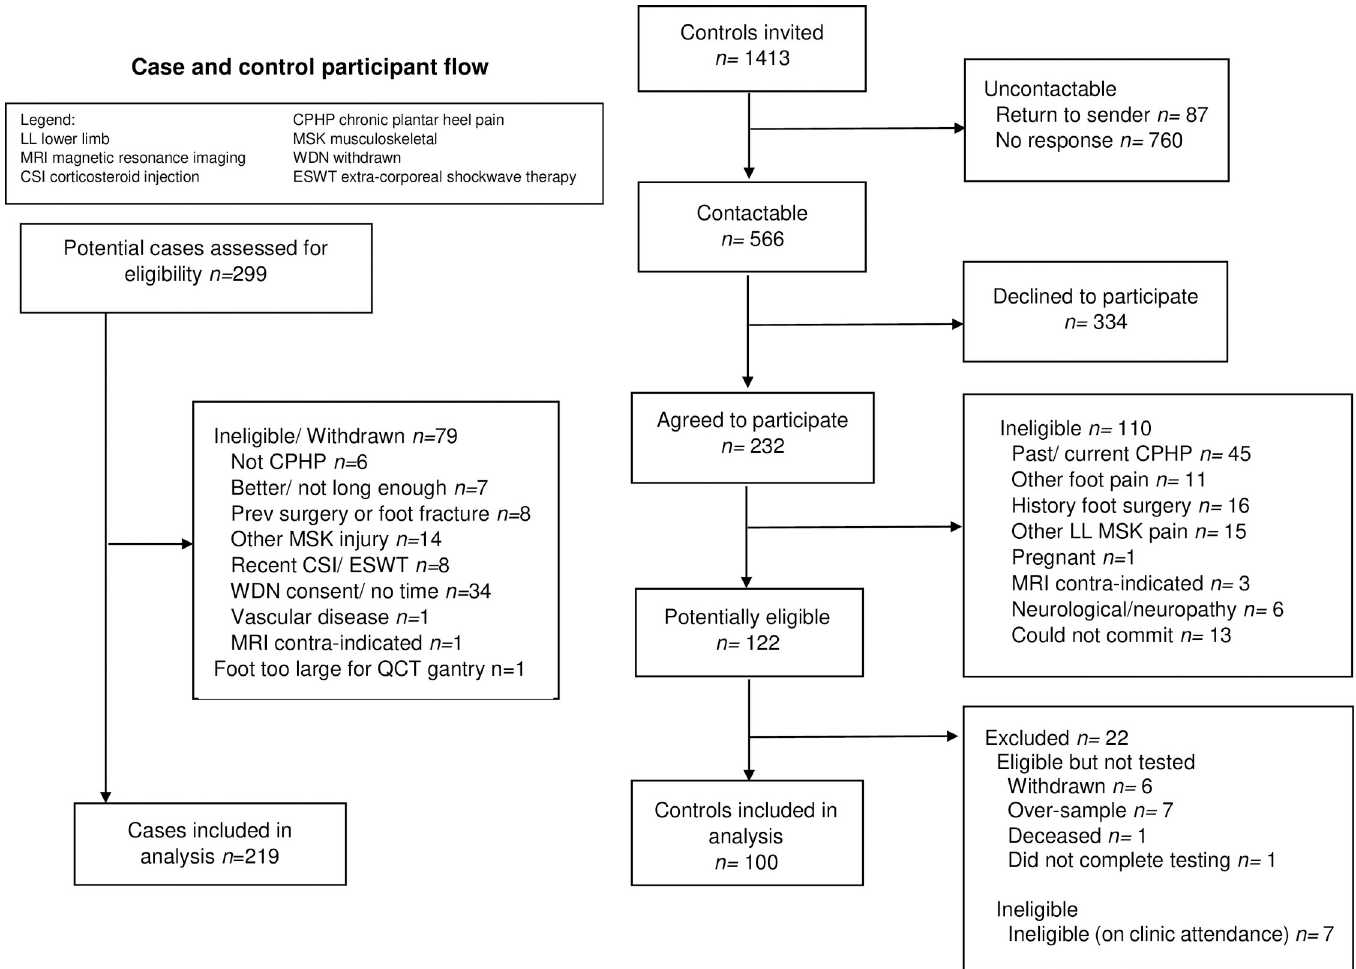
Fig 2. Case and control participant flow.